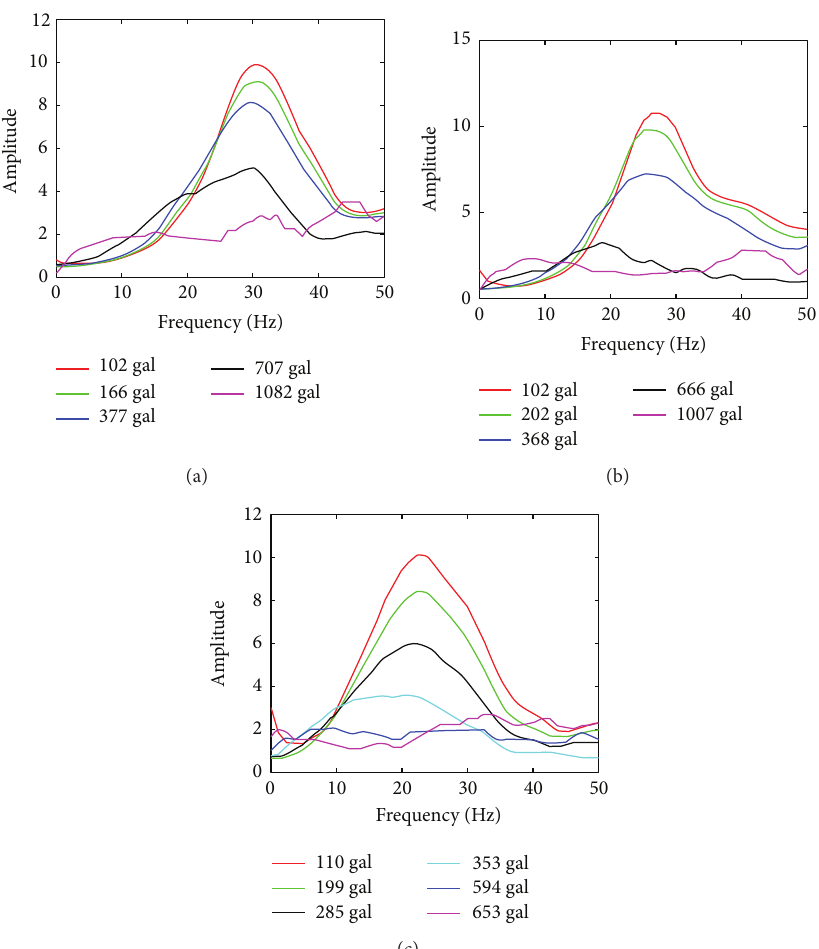
Figure 7: TF spectrum curve at A5 point of slope shoulder of the slope model. (a) Transfer function spectrum (0mm). (b) Transfer function spectrum (10mm). (c) Transfer function spectrum